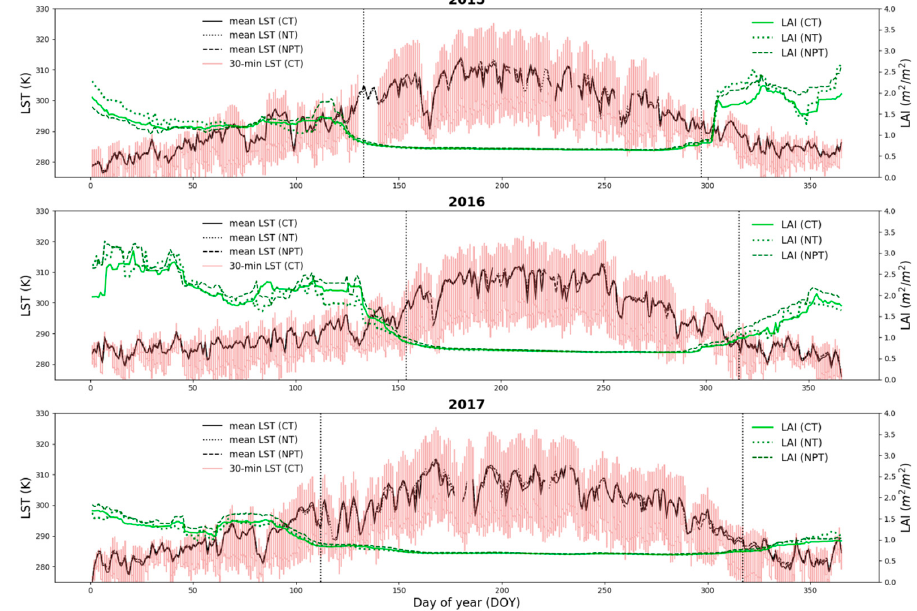
Figure 3. Annual time series of half-hourly LST at CT (red), daily mean LST (black) and ecosystem LAI (green) for CT (solid), NT (dotted) and NPT (dashed) for 2015, 2016 and 2017. Vertical dotted lines indicate transition dates used for TSEB-2S (Section 2.4.4).